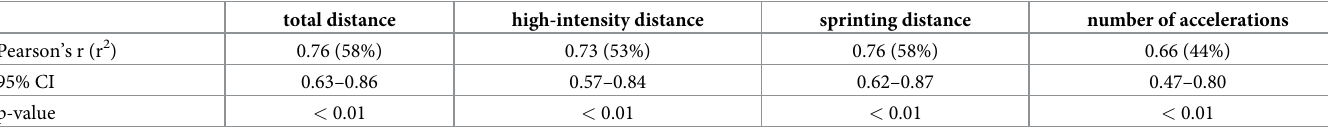
Table 2. Pearson’s r (r 2 ), 95% CI and p-values for correlations between the positional difference of the players in the study sample and the associated positional dif- ference in the normative data for total distance, high-intensity distance, sprinting distance, and number of accelerations.